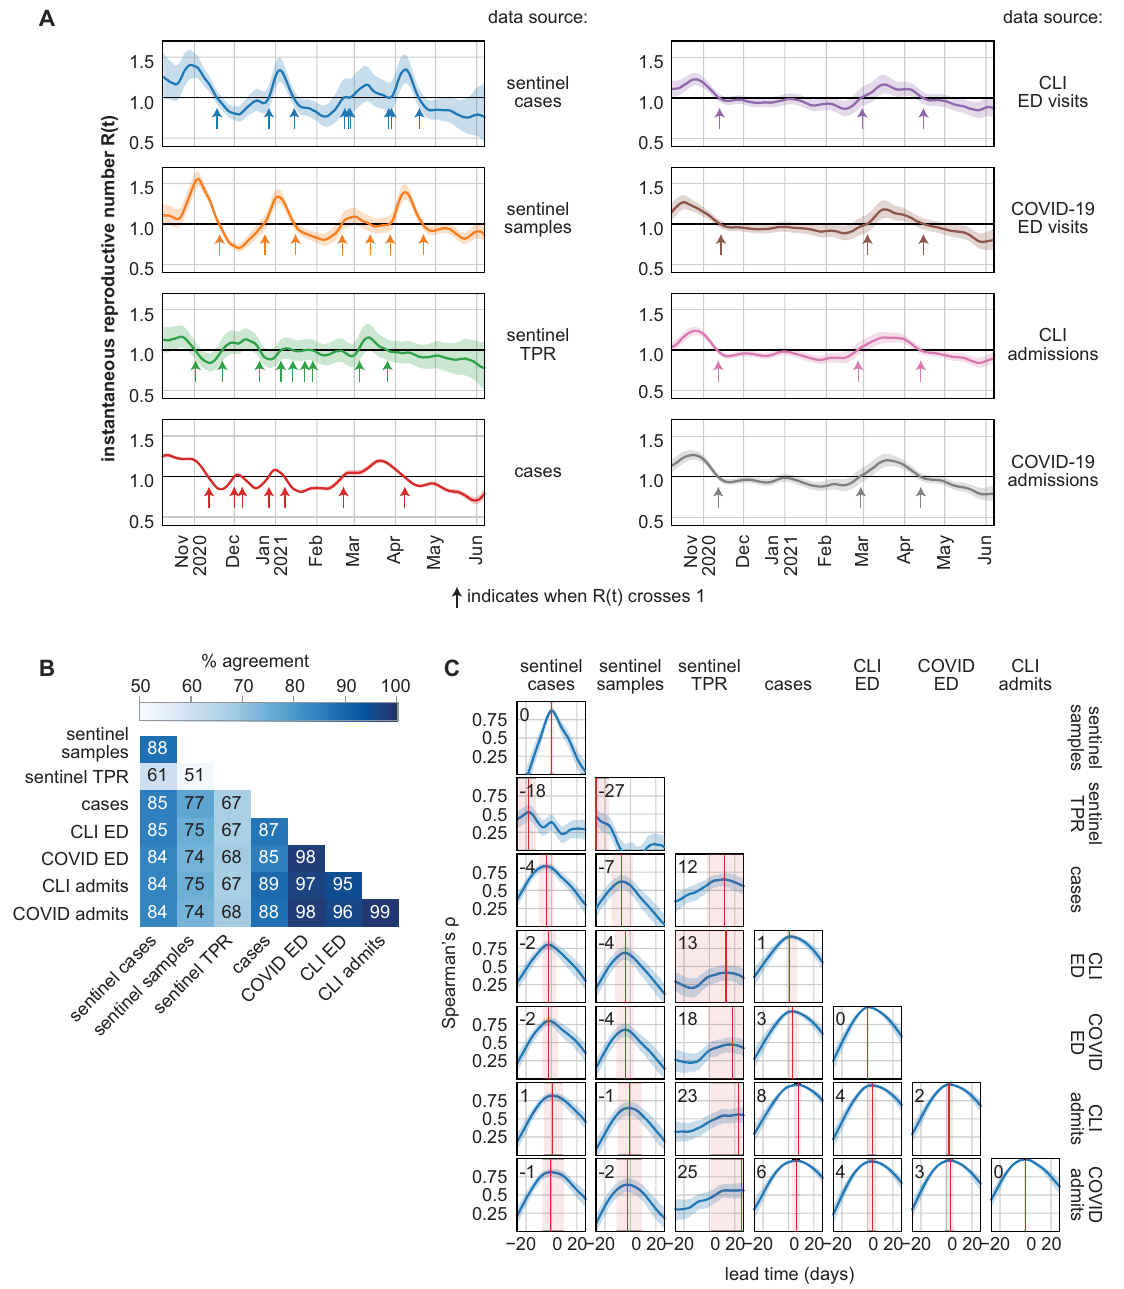
Fig. 4 | Retrospective performance of sentinel cases at quantifying transmis- sionandprovidingleadtimecomparedwithemergencydepartmentvisitsand hospital admissions. A R ( t ) calculated from eight types of surveillance data. Arrows indicate dates at which the median R ( t ) estimate crosses 1.0. Solid lines indicate medianestimate and shaded regionsindicate the 95%con fi dence interval. B Similaritymatrixofpercentagreementbetween R ( t )series.Percentagreementis the percentage of dates when themedian R ( t )estimatesof two seriesareboth ≥ 1.0 or both <1.0. Agreement was also assessed with Spearman ’ s ρ (see Supplementary Fig. S7). C Cross-correlation functions between eight types of surveillance data. Lead time indicates the number of days the series shown on the x-axis was